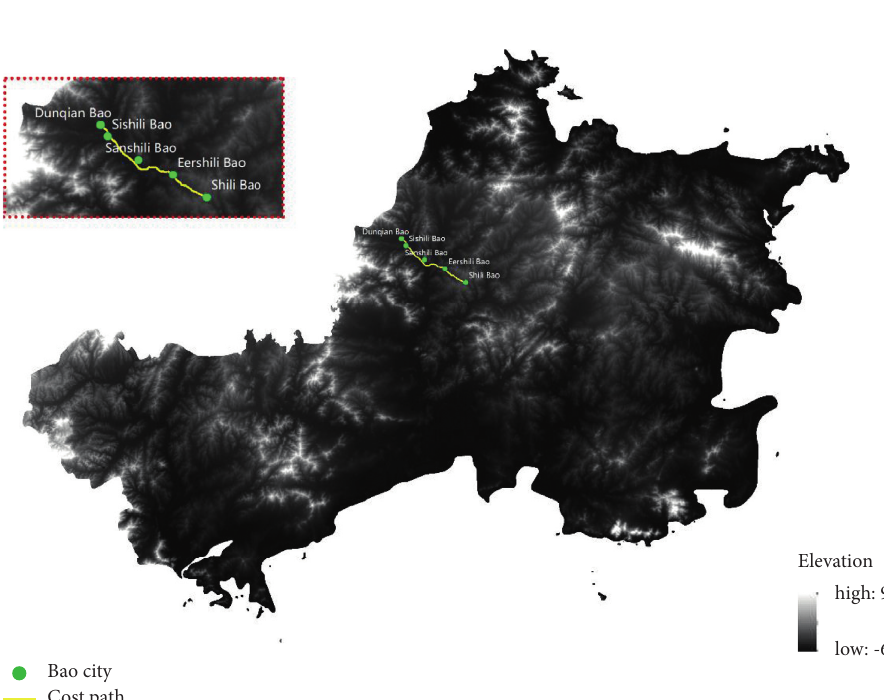
Figure 11: Time cost-based simulation path for ancient military road